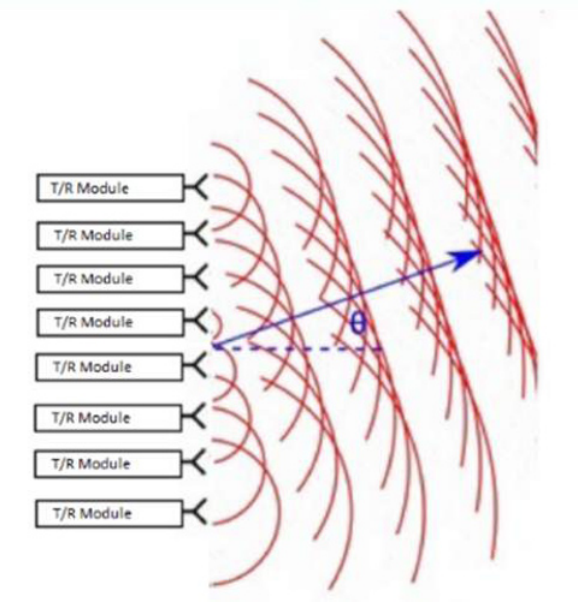
Figure 3. AESA radar architecture showing multiple T / R trans- mitting at a desired angle ( θ ). The red hemispherical lines show the direction of EM radiation